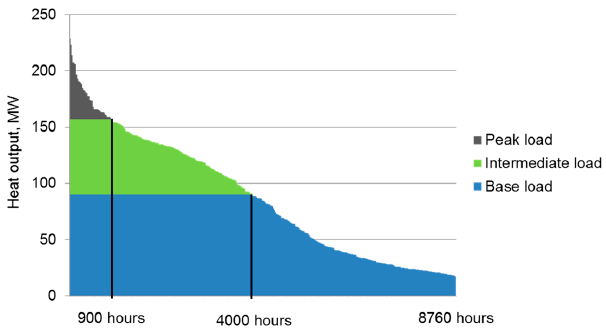
Figure 1. A load duration diagram for Eskilstuna DHS where the duration time limits are presented for the base load and the peak